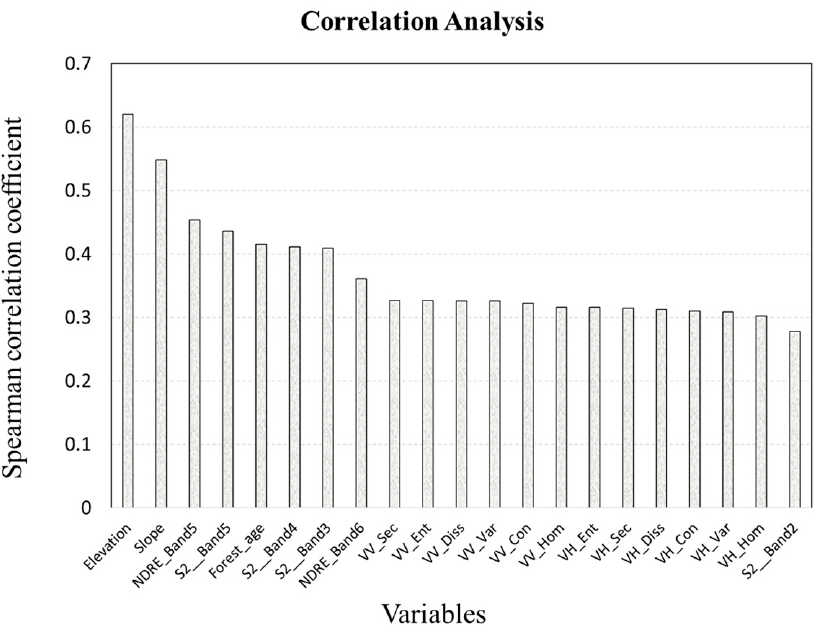
Figure 4. Correlation analysis of the 21 characteristic variables used in the model with canopy height.